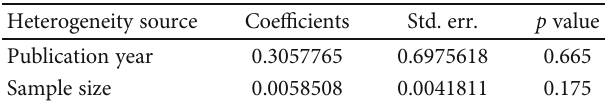
Figure 5: Subgroup analysis of global prevalence of depression in patients with cystic fi brosis. Table 2: Metaregression analysis of factors a ff ecting between-study heterogeneity of depression.